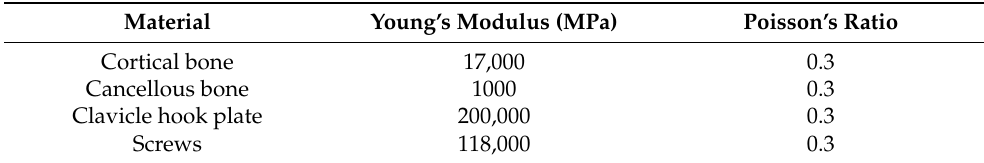
Figure 5. The mesh of the computer models used in this study. Table 1. The material properties [20 – 22].